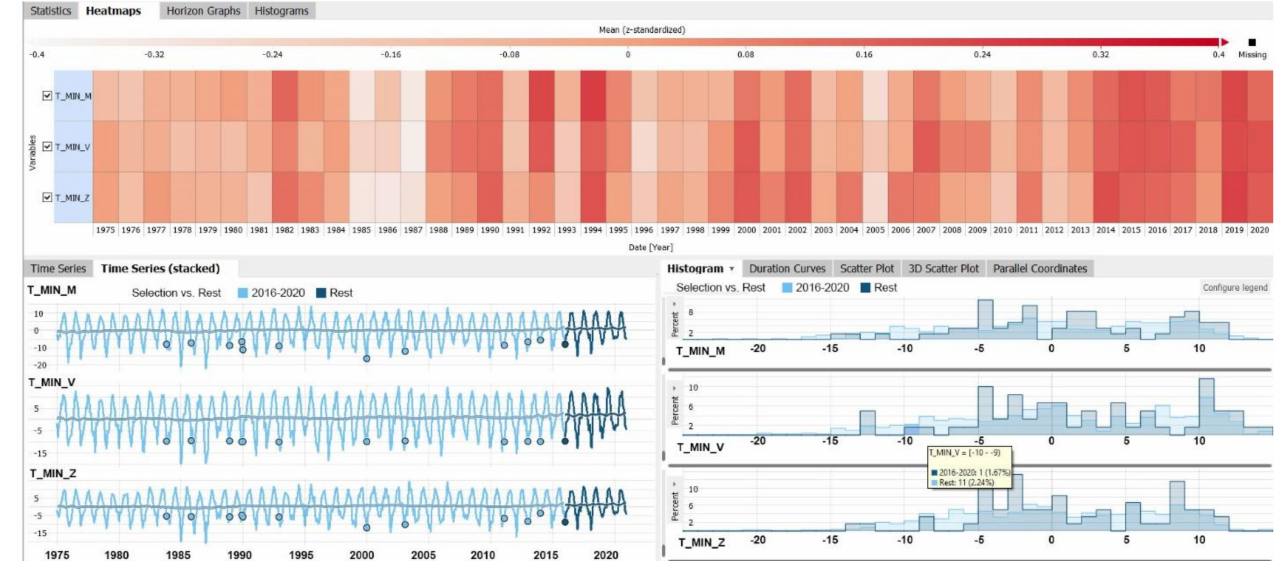
Figure 2. Composite view of temperature time-series (minimum values): heatmap view ( up ), time-series distribution ( down left ), frequency distribution ( down right